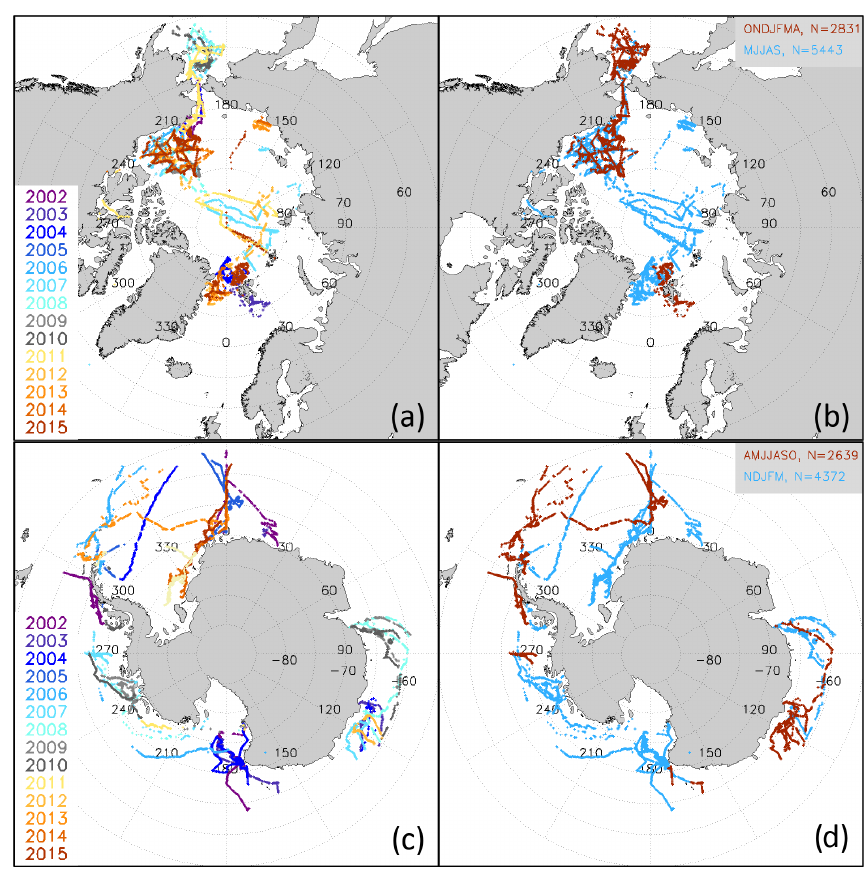
Figure 5. Spatio-temporal distribution of the ship tracks for (a, b) the Arctic and (c, d) the Antarctic from which ship-based visual observa- tions of the sea-ice cover were used. Panels (a, c) illustrate the years, and panels (b, d) distinguish between winter (red) and summer (cyan)